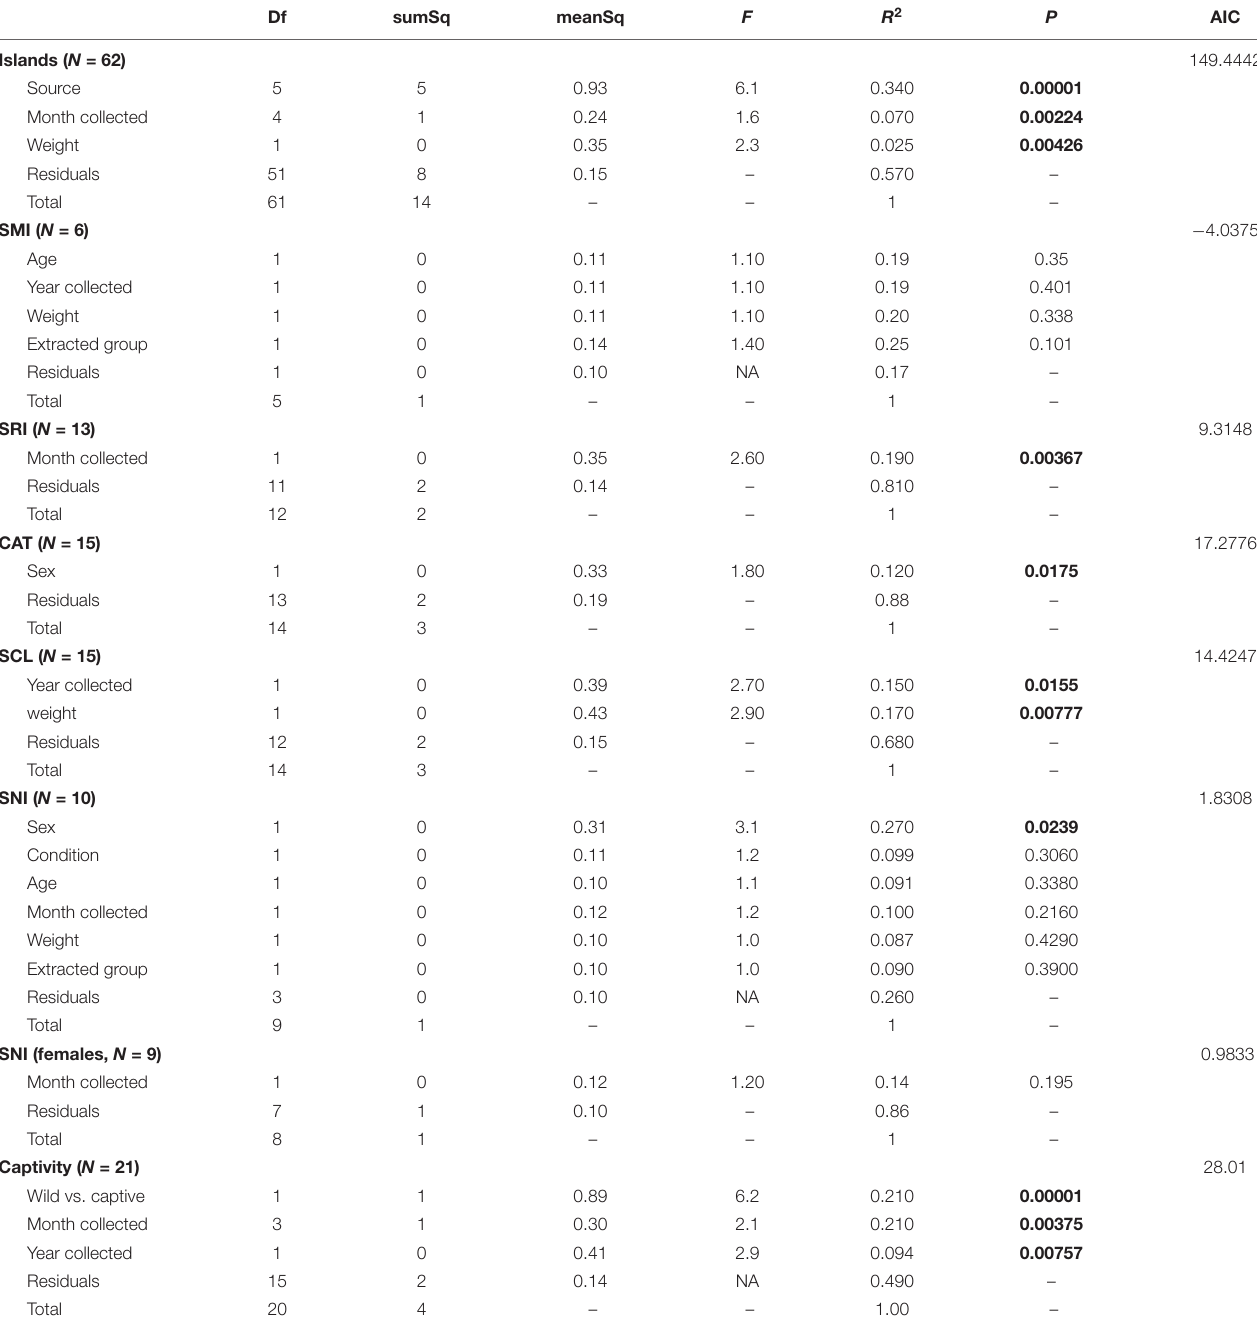
TABLE 1 | Results from the permutational ANOVAs (Bray–Curtis dissimilarity, permutations = 99999) for the best models. Df sumSq